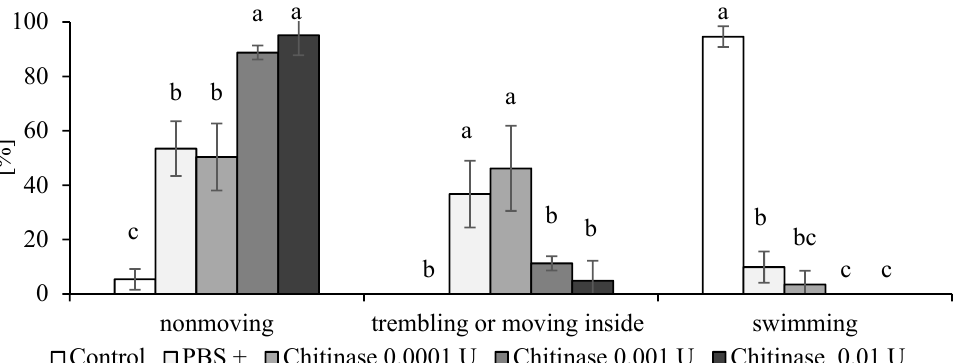
Figure 7. The reaction of the rotifers two hours after the introduction of different concentrations of chitinase; control—no treatment; PBS (phosphate buffered saline) only; the presented results are mean values from five replicates with error bars indicating SD, statistical significance was tested by the one-way analysis of variance (ANOVA) followed by the Tuckey post-hoc test at p ≤ 0.05; bars topped by the same letter (a, b or c) do not differ significantly.